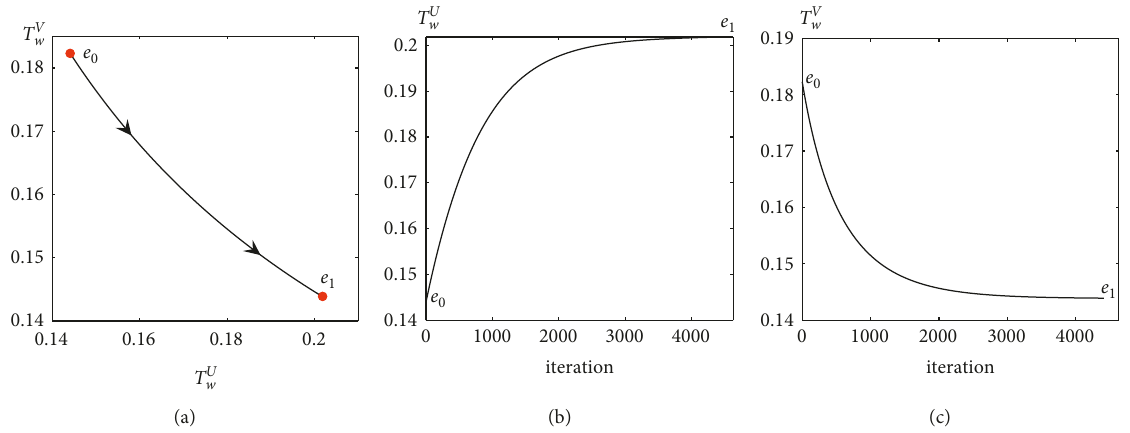
Figure 10: Equilibrium transition when P V � 18 CNY ($2.61) ( θ U � 1 , θ V � ( 1/7 . 2564 )) . (a) Transition path. (b) Evolution of T U Evolution of T V w .